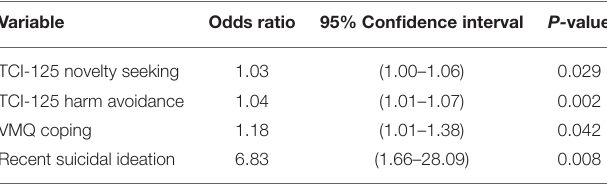
TABLE 3 | Multivariate analysis of factors associated with dual diagnosis among gaming disorder patients ( N = 92). Variable